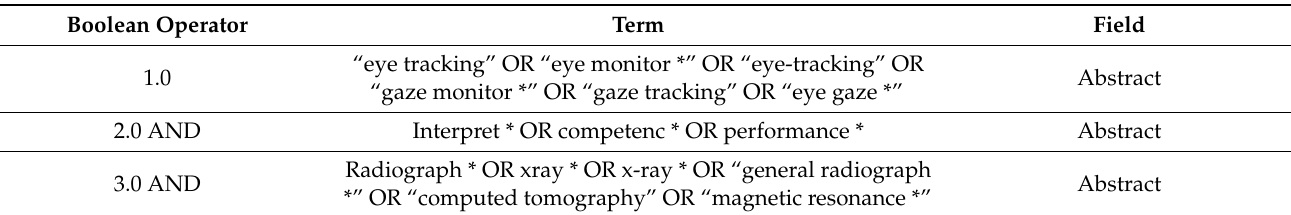
Table 1. Use of a combination of search terms to locate relevant studies.